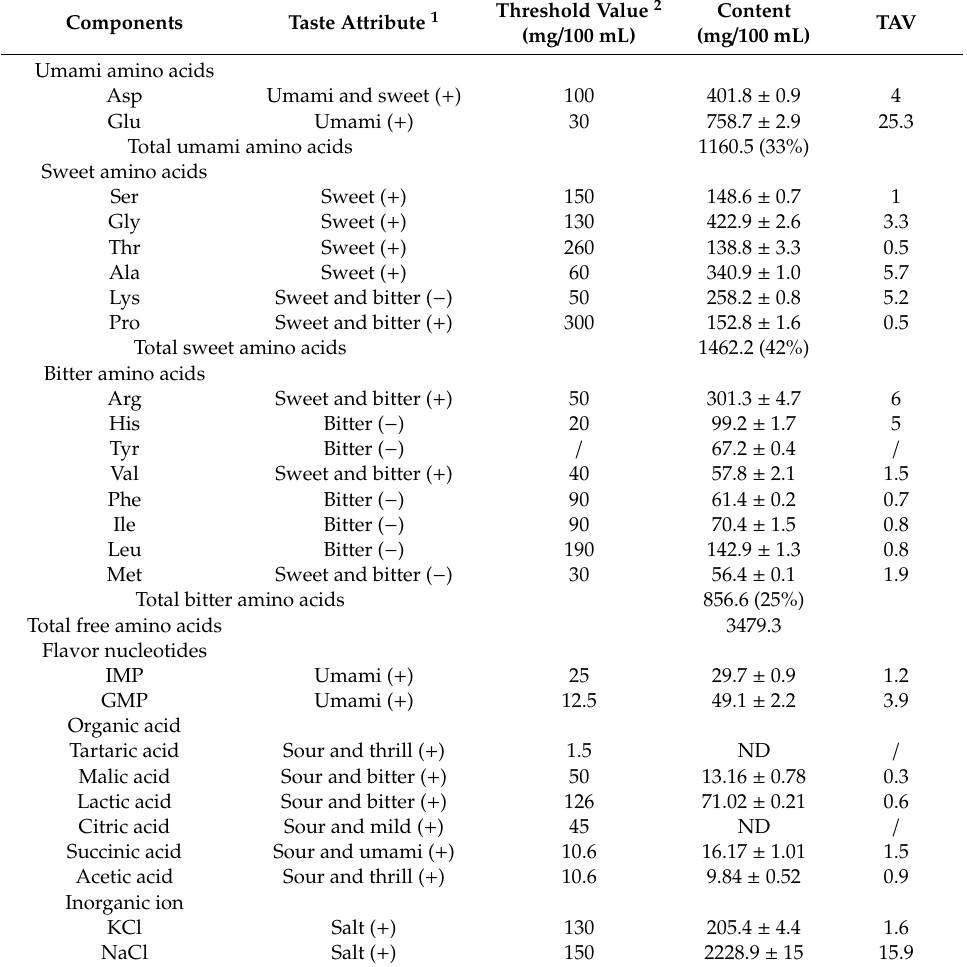
Table 1. The contents, taste attributes, taste threshold and TAV of the putative non-volatile taste-active components in crab sauce (mean ± SD).